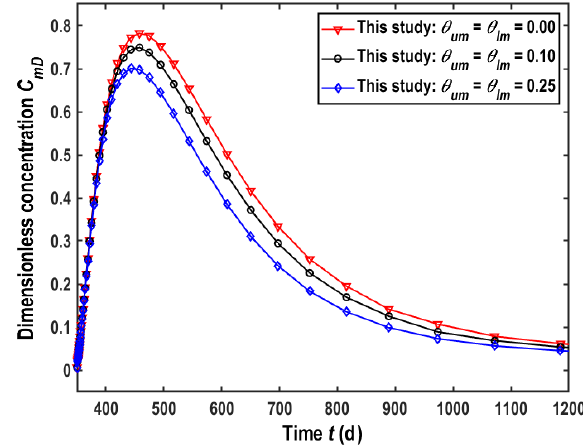
Figure 6. Comparison of BTCs between the model with and without aquitards for different